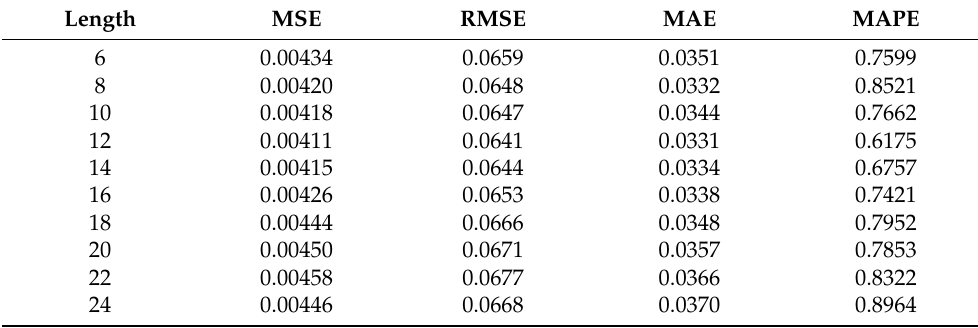
Table 3. Performance of our proposed method under different data